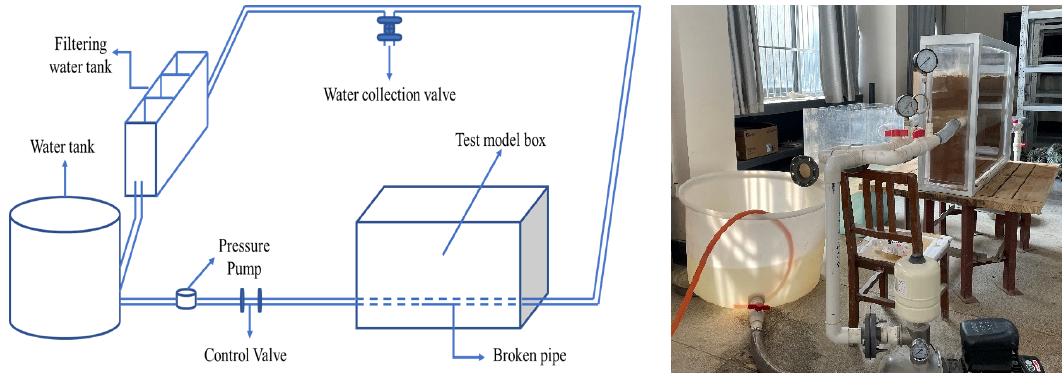
Figure 2. Experimental equipment.